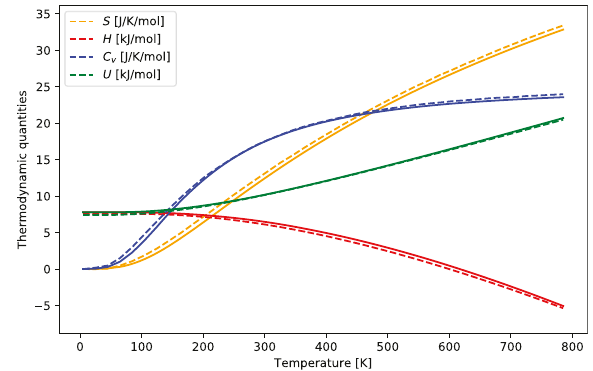
Fig. 3 Example prediction of MODNet on vibrational thermo- dynamics. MODNet predictions (dashed line) and DFPT values (solid line) for the thermodynamic quantities of Li 2 O (MPID: mp-1960) as a function of the temperature. Observed errors on this particular sample are close to the overall MAE of the test